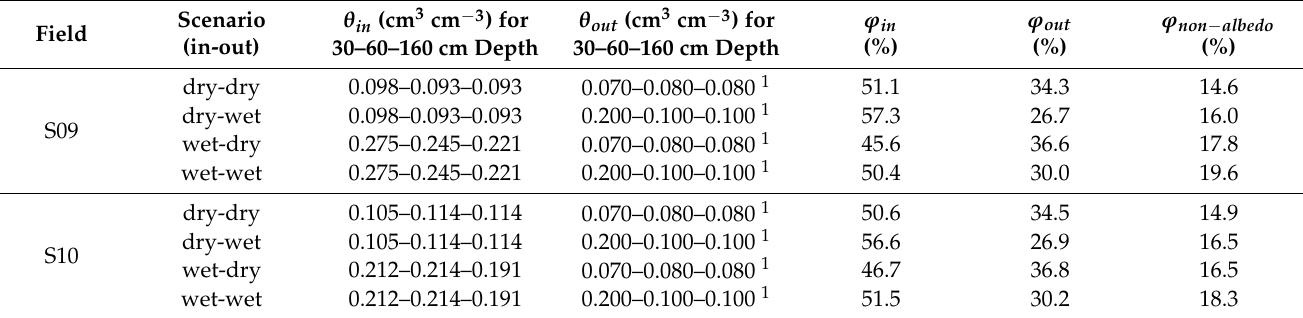
Table 3. SM values used to produce new URANOS neutron transport simulations using combinations of θ in and θ out , and the resulting subdivision of N